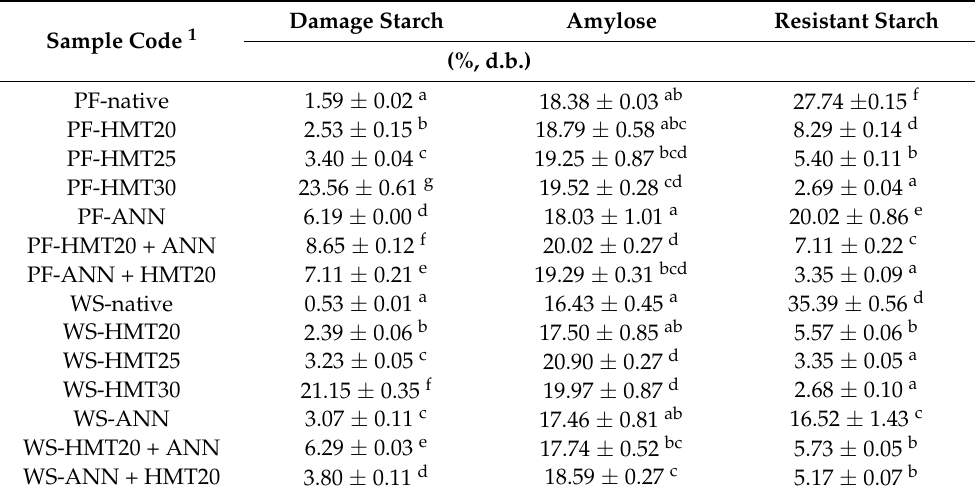
Table 2. Starch compositions of native/modified lotus rhizome starches on dry basis 2